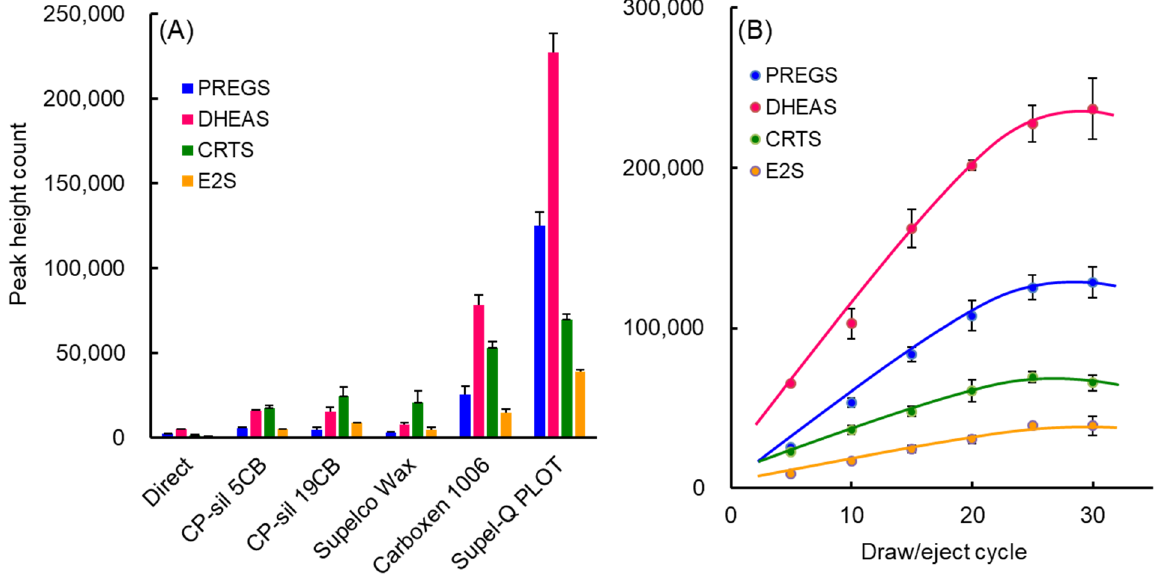
Figure 1. Effects of ( A ) capillary coatings and ( B ) number of draw/eject cycles on the IT-SPME of sulfated steroid metabolites. Standard solution containing 1 ng mL –1 each of PREGS, DHEAS, and CRTS and 5 ng mL –1 of E2S were extracted by ( A ) 25 draw/eject cycles of 40 μ L of standard solution at a flow rate of 200 μ L min –1 , and ( B ) the indicated number of draw/eject cycles of 40 μ L of standard solution on a Supel-Q PLOT capillary at a flow rate of 200 μ L min –1 .